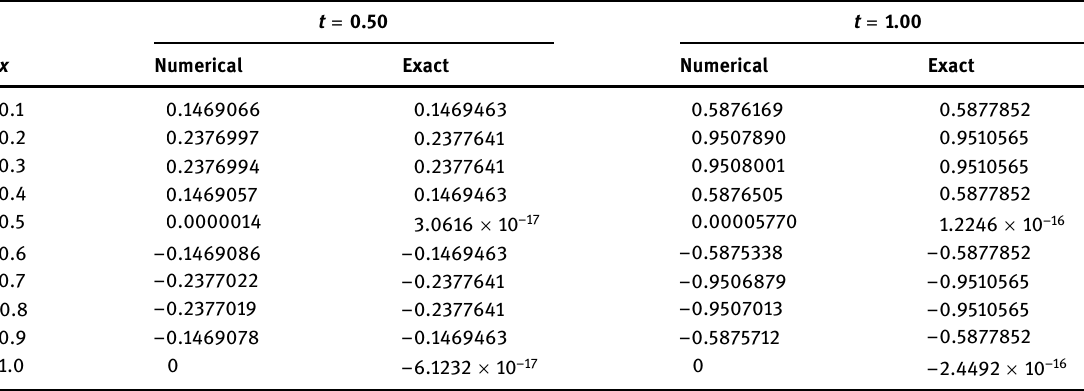
Table 8: U i j , and u i j , with α 0.5 =